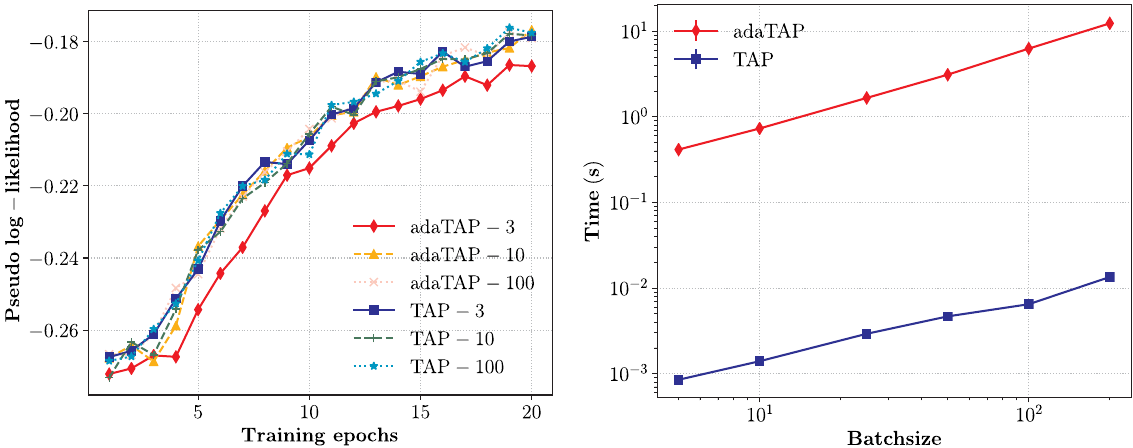
FIG. 10. Left: Evolution of the pseudolikelihood along the training of an RBM with 784 binary visible units and 500 binary hidden units. Training is performed using the 5000 first images of binarized MNIST, with a learning rate of 0.001 and batches of size 100. The different curves correspond to different strategies of estimation of the likelihood gradients, with either TAP or adaTAP. Both algorithms are iterated for a fixed number of times (3, 10, and 100). In all cases, a damping of 0.5 is used. All methods yield comparable results in terms of training performance, except for adaTAP with only three iterations, which shows a poorer performance. Right: Computation time for one iteration of the inference algorithm, as a function of the batch size. Time is reported in seconds for identical experimental settings. The need for a matrix inversion for each batch element makes VAMP 3 orders of magnitude slower than